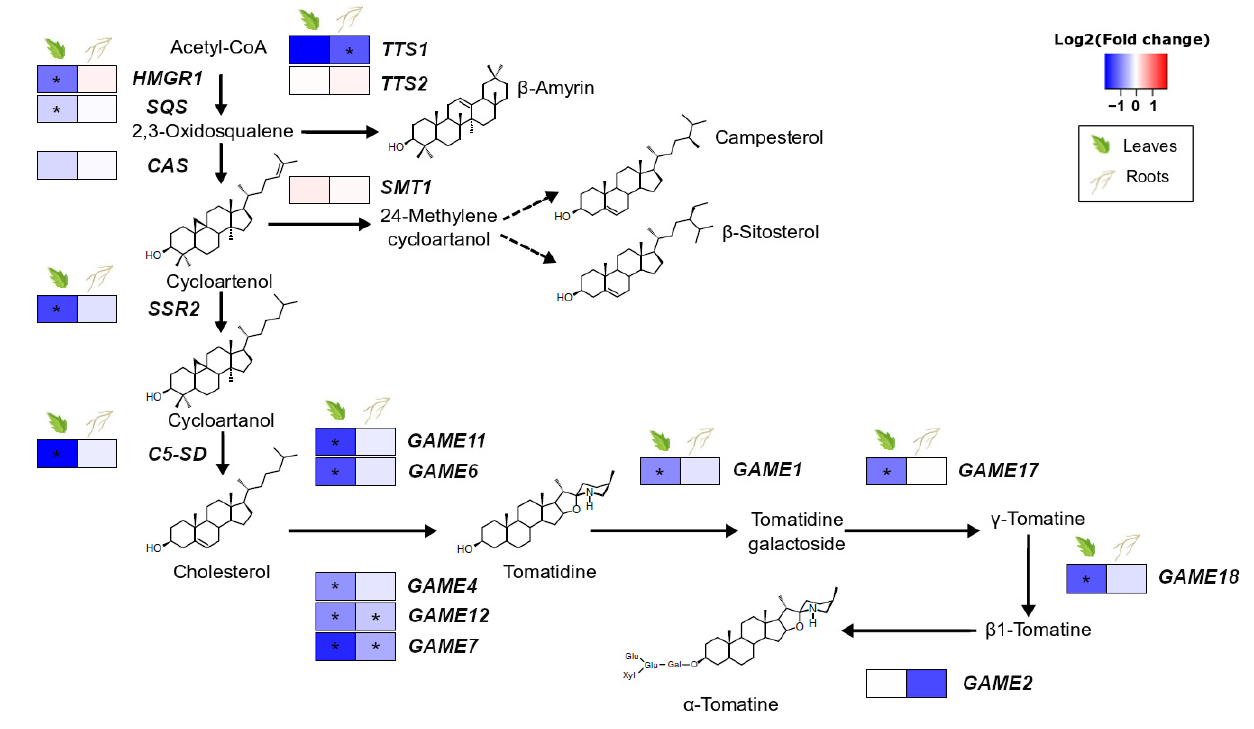
Figure 2. Effect of S. indica colonisation on the expression of genes involved in the biosynthetic pathway of sterol precur- sors and glycoalkaloids in tomato leaves and roots. Changes in gene expression between tissues from inoculated plants and tissues from endophyte-free plants are represented as log 2 of the fold change in the form of a heatmap. Data derived from RNA sequencing of leaves and roots from S. indica -colonised and endophyte-free plants. Asterisks (*) indicate FDR- corrected p ≤ 0.05. HMGR1, 3-hydroxy-3-methylglutaryl-CoA reductase; SQS, squalene synthase; CAS, cycloartenol syn- thase; SSR2, sterol side-chain reductase 2; C5/SD, Δ (7)-sterol-C5-desaturase; TTS1, triterpenoid synthase 1; TTS2, triterpe- noid synthase 2; SMT, sterol methyltransferase; adaptedfrom